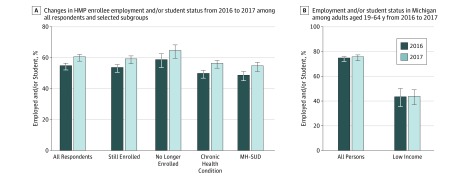
Changes in Enrollee Employment or Student Status From 2016 to 2017 Among All Respondents and Selected SubgroupsA, Persons with chronic health conditions included survey respondents with 1 claims-based diagnosis of a chronic physical health condition. Mental health or substance use disorder (MH-SUD) included survey respondents with 1 claims-based diagnosis of a chronic behavioral health condition, including mental health disorders and/or substance use disorders. B, Low income is defined as persons whose household income is at or below 125% of the federal poverty level.This census category approximates Healthy Michigan Plan (HMP) income eligibility, which is 138% of the federal poverty level. Employed and/or student includes those who are employed or are full-time or part-time students. Weighted percentages are presented. Error bars indicate 95% CIs. P < .05 for employment or student status change among HMP enrollees from 2016 to 2017 for all comparisons, estimated from mixed-effects logistic regression model with time indicators but no covariates. P > .05 for comparisons among adults aged 19 to 64 years in Michigan.